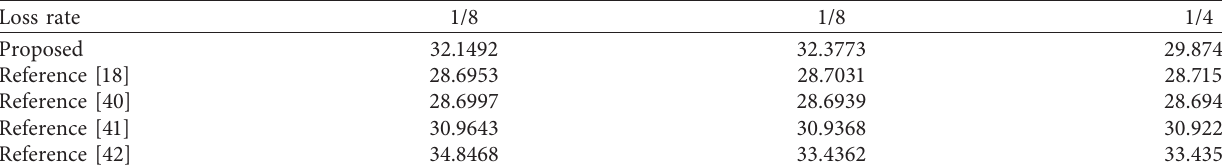
Table 10: Data loss analysis